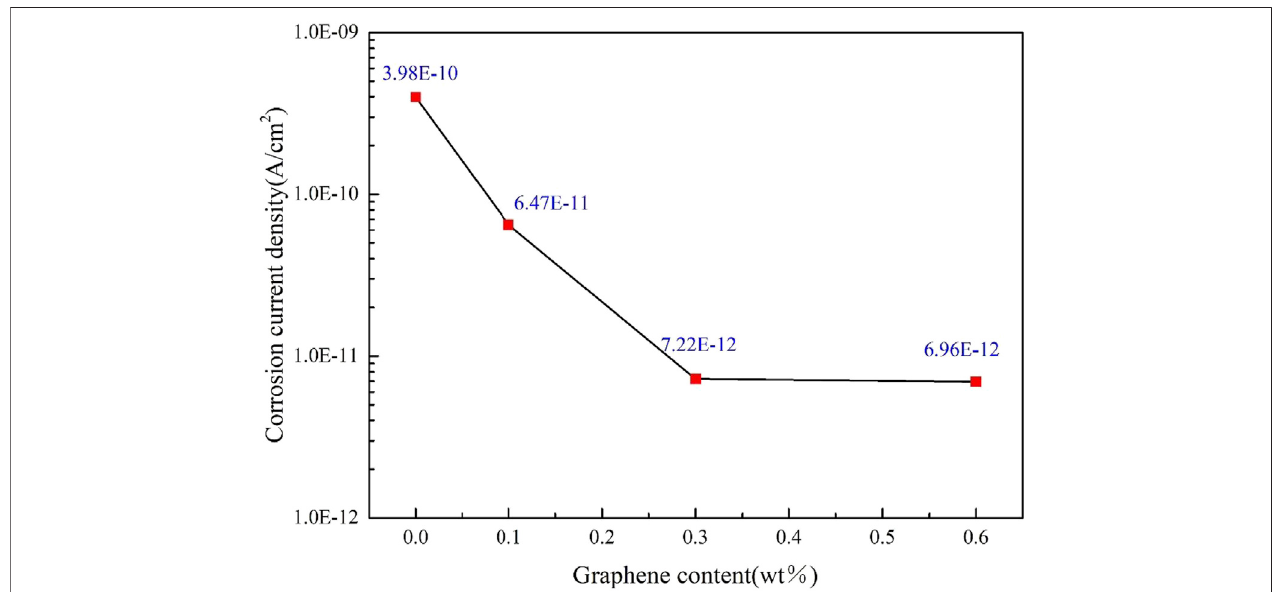
FIGURE 6 | Variation trend of corrosion current density of oily epoxy resin coating with different graphene content.